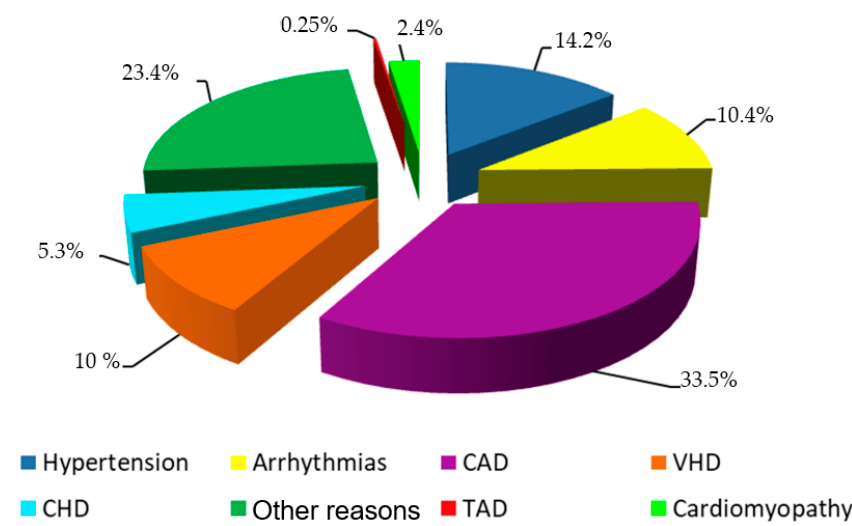
Figure 1. The pipeline for medical risk model development.